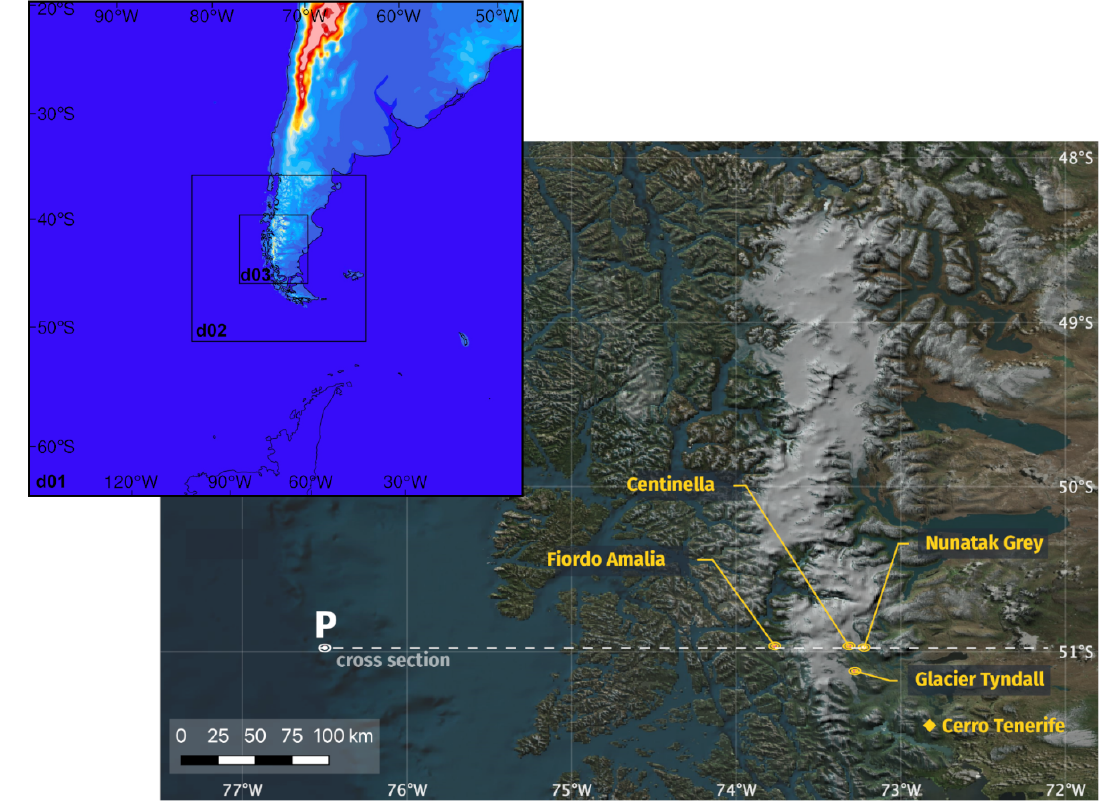
Figure 1. Topographic overview of the study site. Yellow dots mark the four AWSs, the yellow square marks the location of Cerro Tenerife, the white dashed line displays the course of the cross sections and “P” indicates the location of upstream profiles. The inlay shows the Weather Research and Forecasting (WRF) model domains and topography. Table 1. Automatic weather stations (AWSs) and their locations, measured variables (air temperature Table 2. Sensor types and accuracies of AWSs Centinella (CE) and Nunatak Grey Dir and precipitation R ) and recording times.